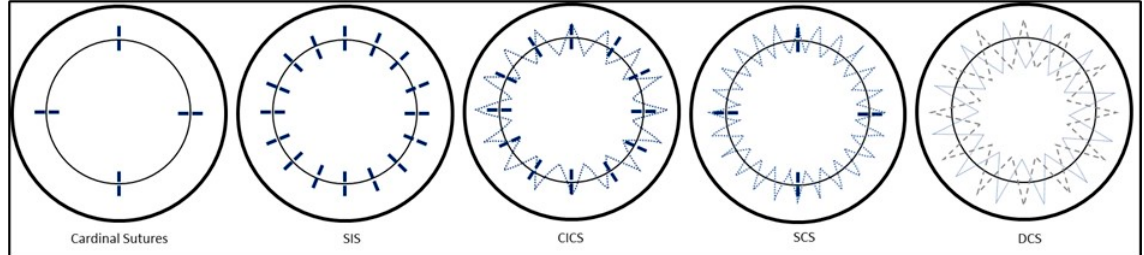
Figure 3. Types of corneal sutures. SIS = single interrupted sutures, CICS = combined interrupted and continuous sutures, Single CRS = single continuous running suture, DCS = double continuous suture.